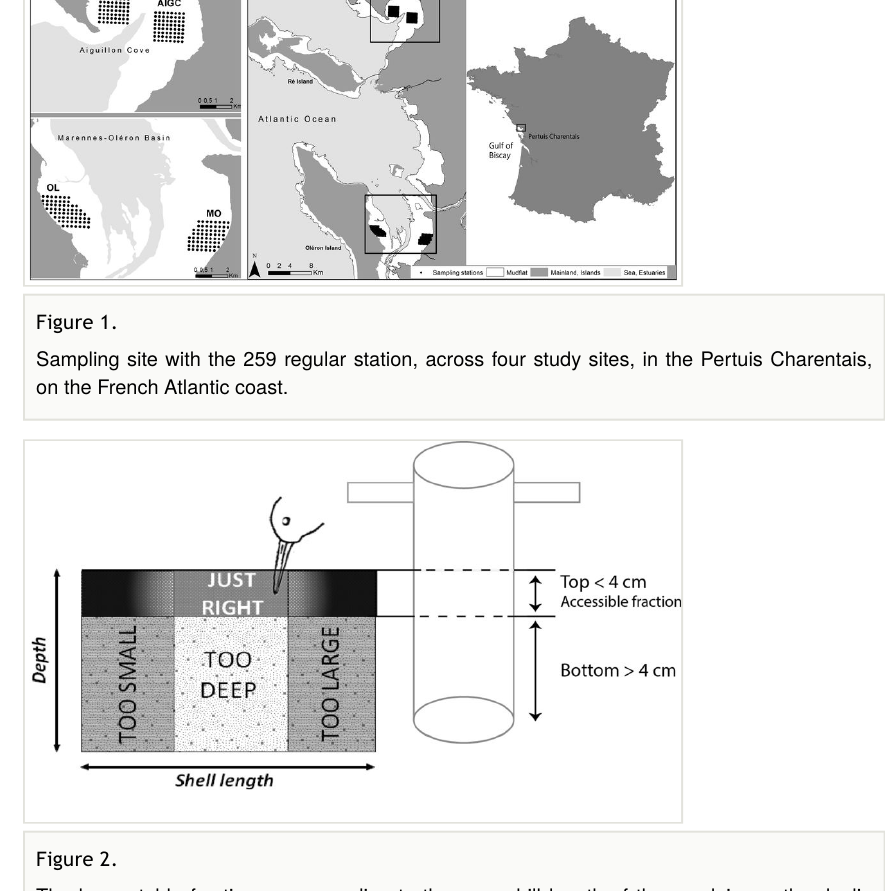
The harvestable fraction corresponding to the mean bill length of the sandpipers, the dunlin Calidris alpina and the red knot Calidris canutus and composed of the accessible fraction of benthos (found in the top 4 cm of the mud core) and of ingestible sizes (not too large and not too small). Ingestible sizes are species speci fi c, and depend on the shape of the mollusc. Sizes available for C. canutus and C. alpina species are reported in Philippe et al.